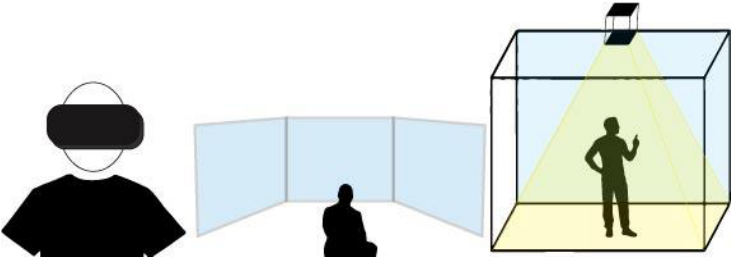
Figure 1. A representation of a head-mounted display, large screen projection system and cave automatic virtual environment.